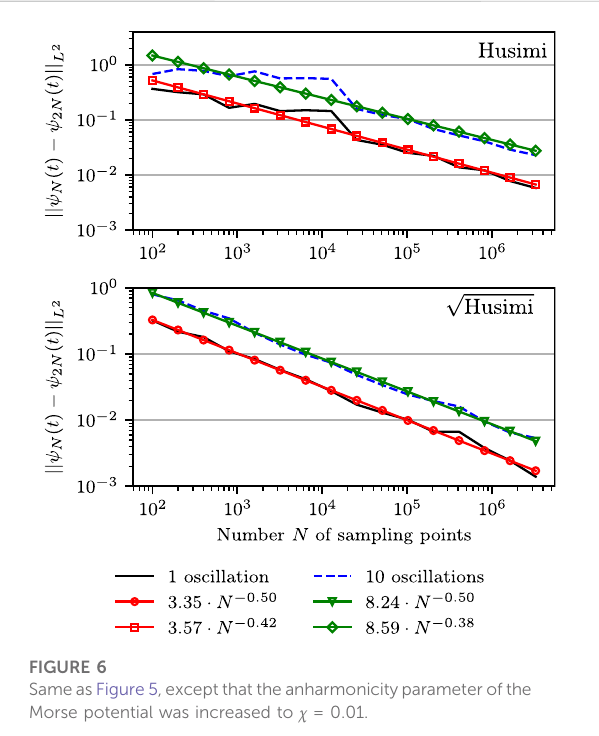
FIGURE 7 Position probability densities (upper panel) and their absolute errors (lower panel) in a Morse potential with χ = 0.01 after 10oscillations(2020timesteps ≈ 392fs).Positionprobabilitydensities of the Herman – Kluk approximation for (Case H) and (Case sqrt- H) were computed with N = 800 trajectories.